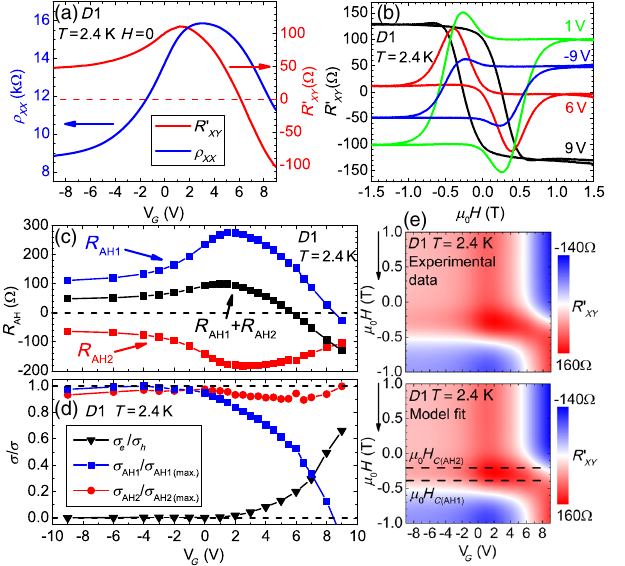
FIG. 2. (a) Zero-field ρ xx and R 0 xy of our device as a function of gate voltage. (b) Magnetic field dependence of the offset corrected Hall resistance ( R 0 xy ) as a function of magnetic field for various gate voltages. (c) Strength of each of the contributions extracted from the data. (d) The two normalized anomalous Hall conductivity components as a function of gate voltage compared to the ratio between electron and hole Drude conductivity extracted from the high field data (see Supplemental Material [32]). (e) Color plot confirming the agreement between the experimental data (top) and the description provided by our model (bottom).